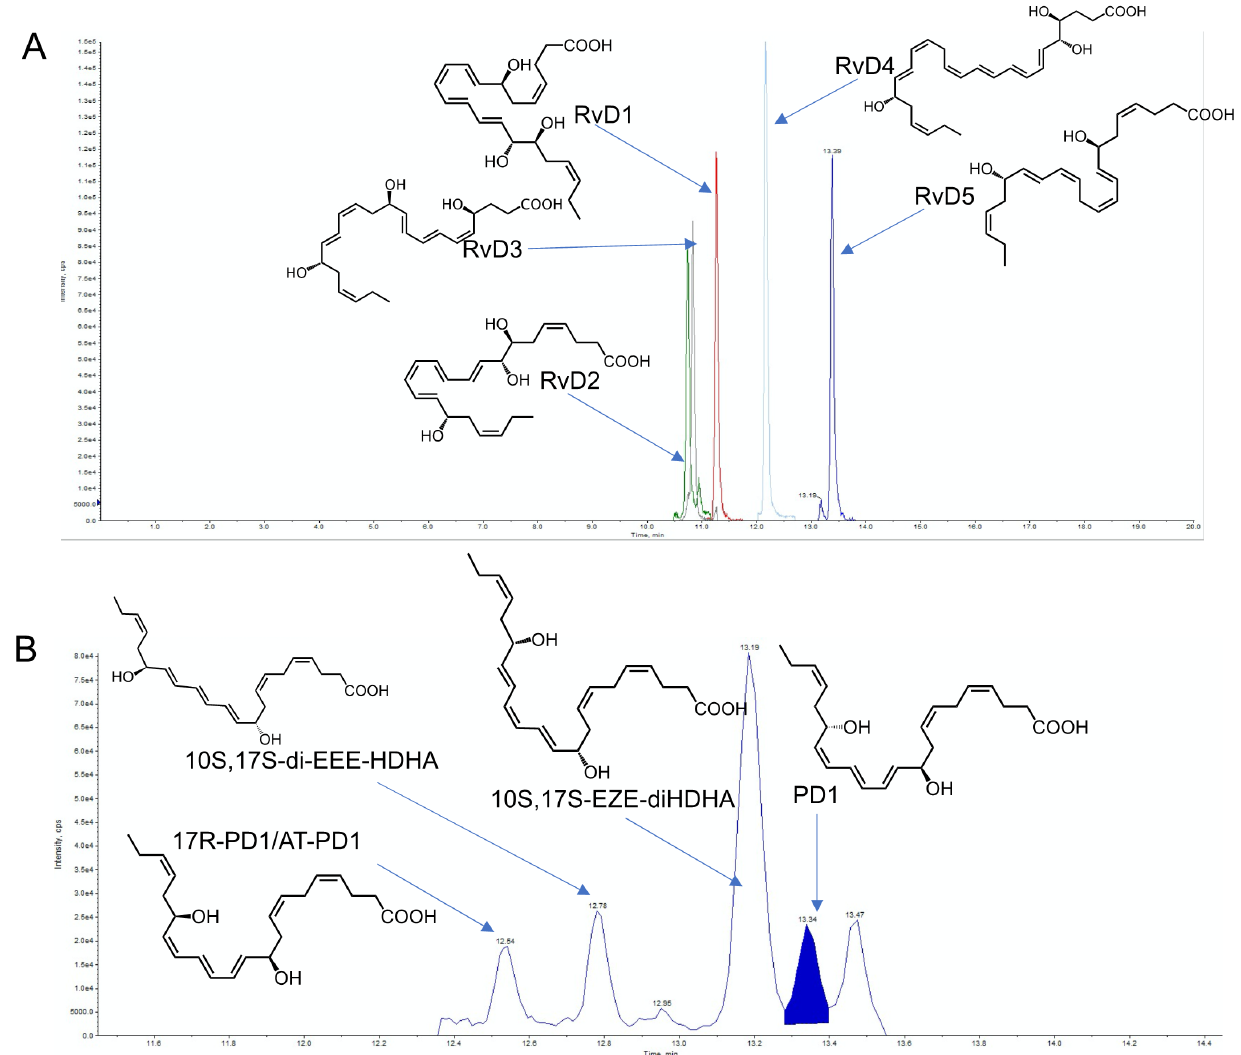
Figure 2. Separation of specialized pro-resolving mediators using Reverse Phase High Pressure Liquid Chromatography. Representative examples of ( A ) the chromatographic separation of DHA derived D-series resolvins demonstrating the separation of both di- and tri-hydroxylated species as well as positional isomers and ( B ) DHA-derived Protectins (PD) demonstrating the chromatographic separation of double bond and chiral isomers using RP-HPLC. Conditions employed in the separation and identification of these autacoids are as follows: samples were injected using a Shimadzu LC-20AD HPLC and a Shimadzu SIL-20AC autoinjector, paired with a QTrap 6500+ (Sciex). An Agilent Poroshell 120 EC-C18 column (100 mm × 4.6 mm × 2.7 µ m) was kept at 50 ◦ C and